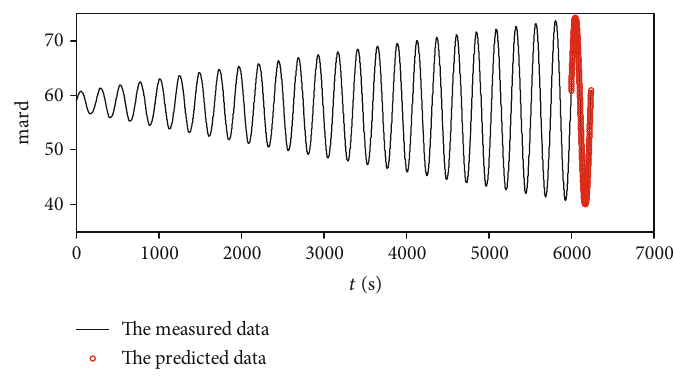
Figure 6: The prediction value and measured value.